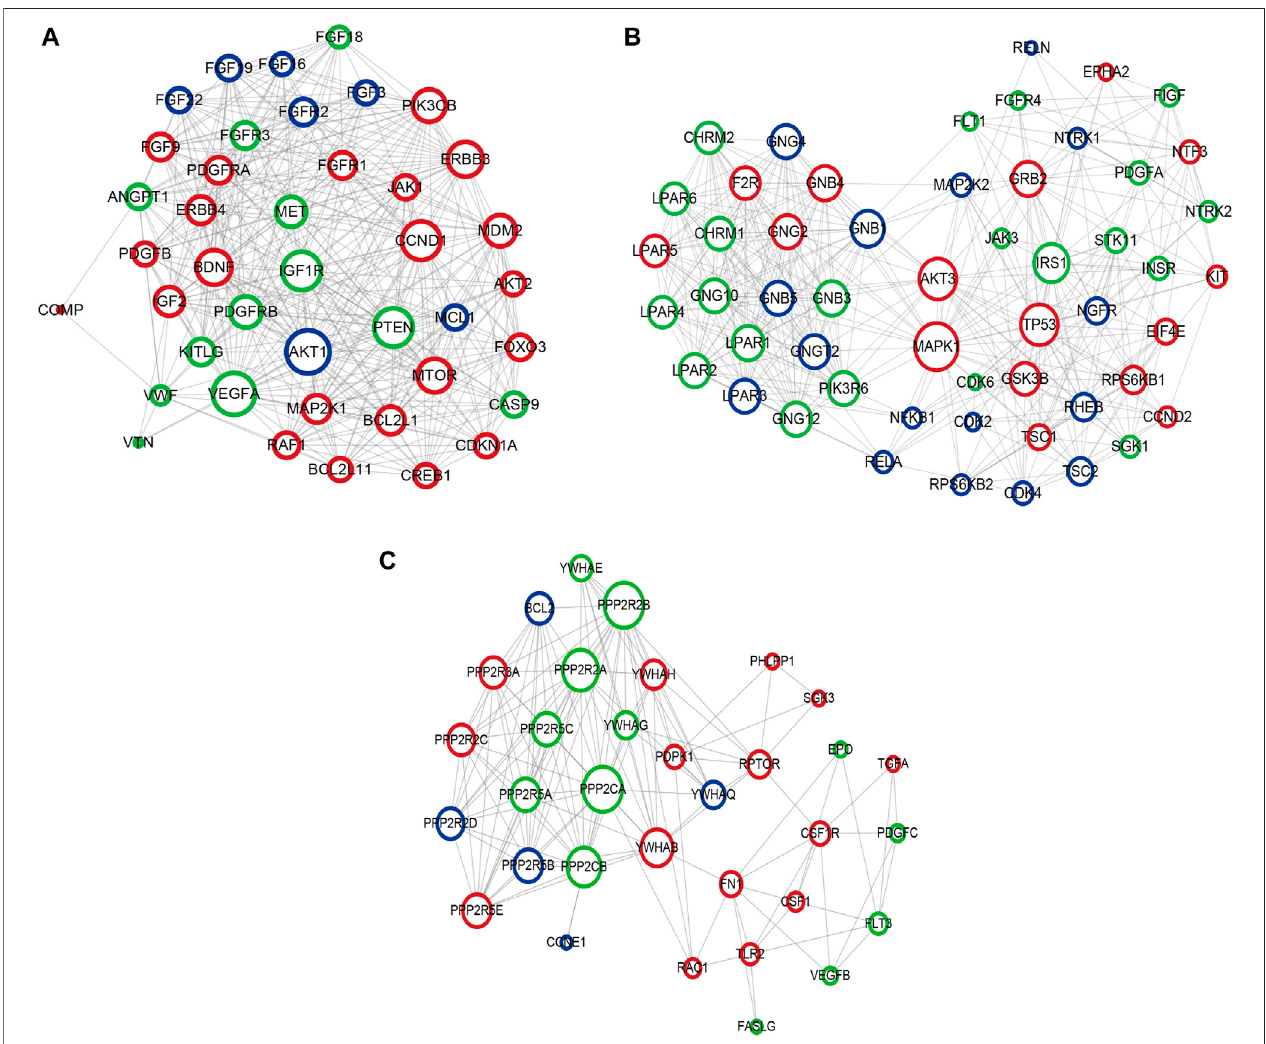
FIGURE 10 | Crucial modules in PPI network of PI3K-Akt signaling pathway. (A) module one, (B) module two, (C) module three. Green circles represent miR-96 target genes, blue circles represent miR-99b target genes, the common target genes are in red.